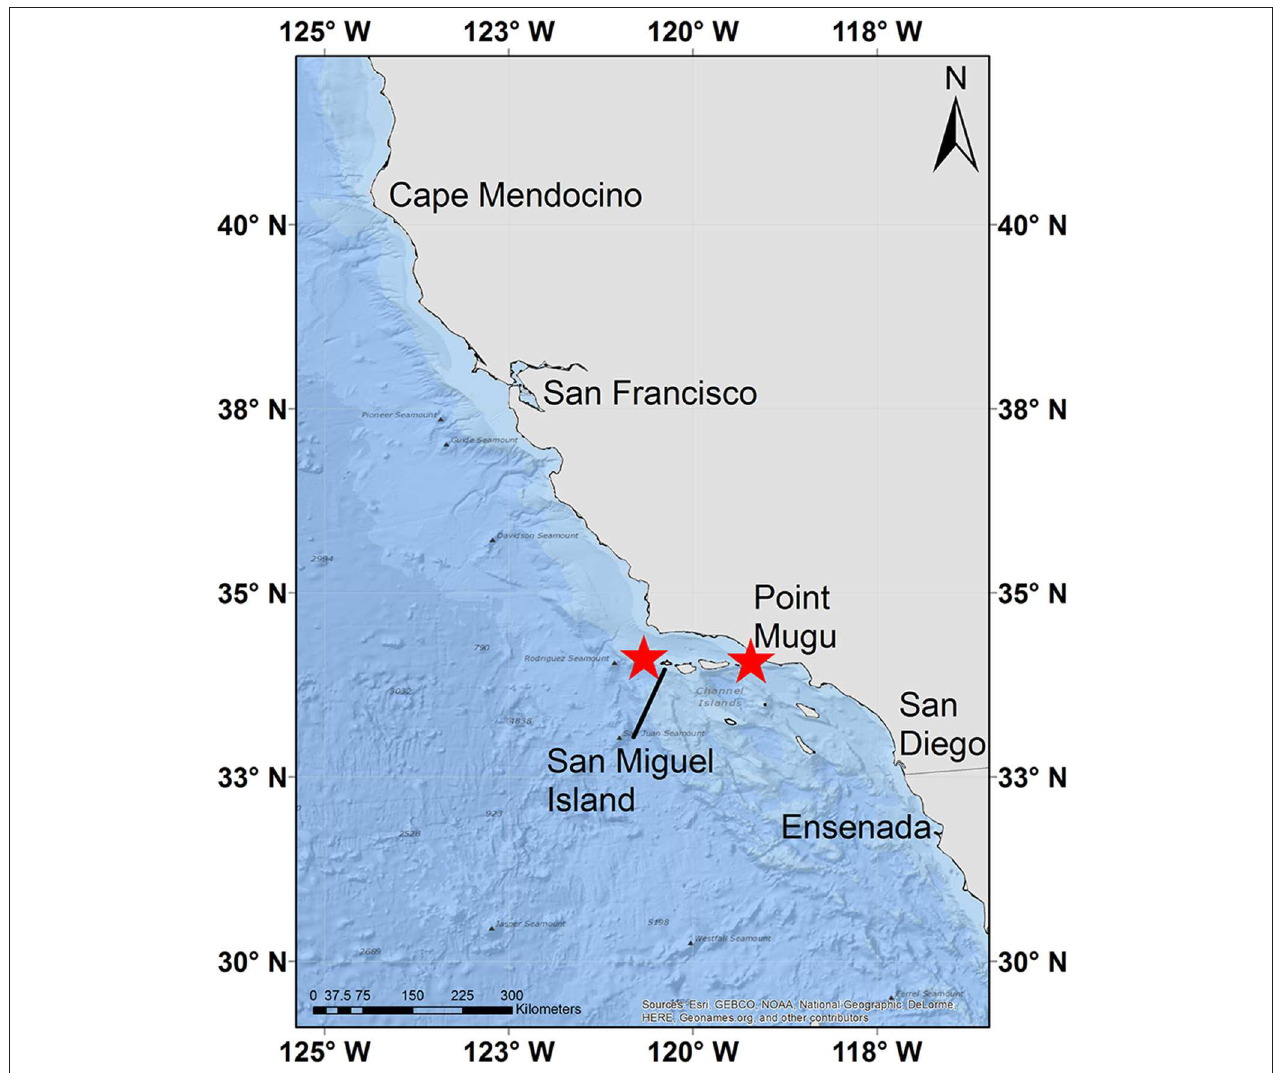
FIGURE 1 | A map of the study area with ADB tag deployment locations marked by red